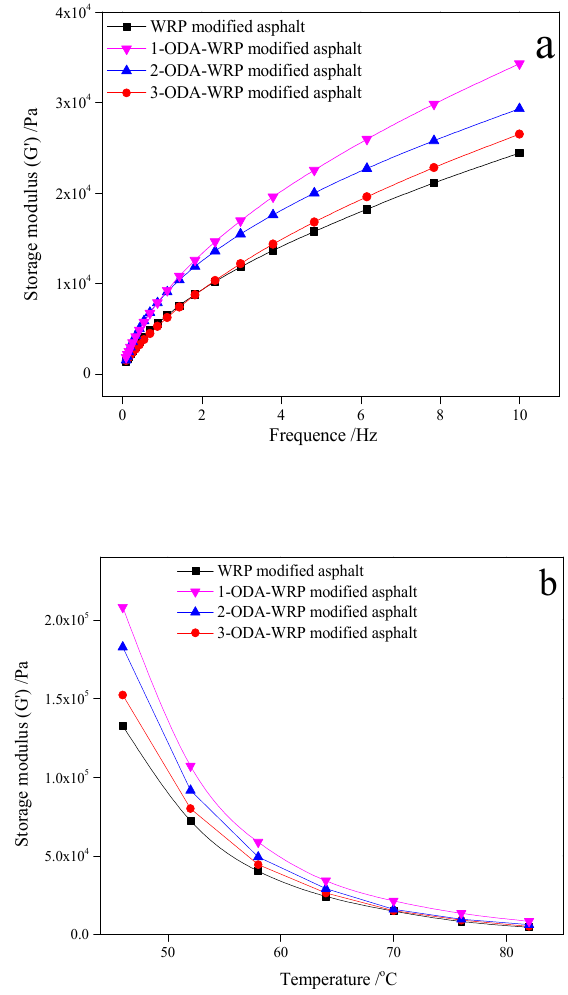
Figure 5. Variation in G' with: ( a ) frequency at 64 °C and ( b ) temperature at 10 Hz for different kinds of ODA-WRP asphalt.